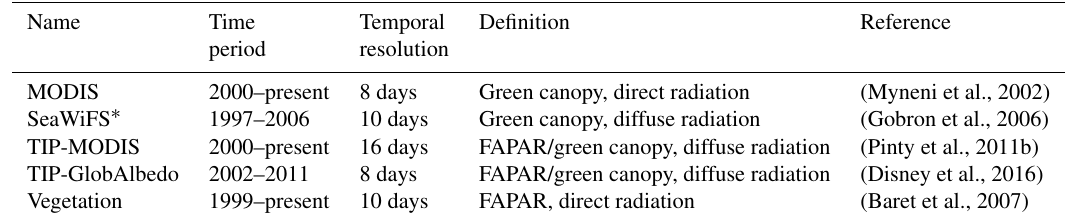
Table 2. Characteristics of a variety of FAPAR products; more details and products are provided by D’Odorico et al. (e.g. 2014); Pickett- Heaps et al. (e.g. 2014).